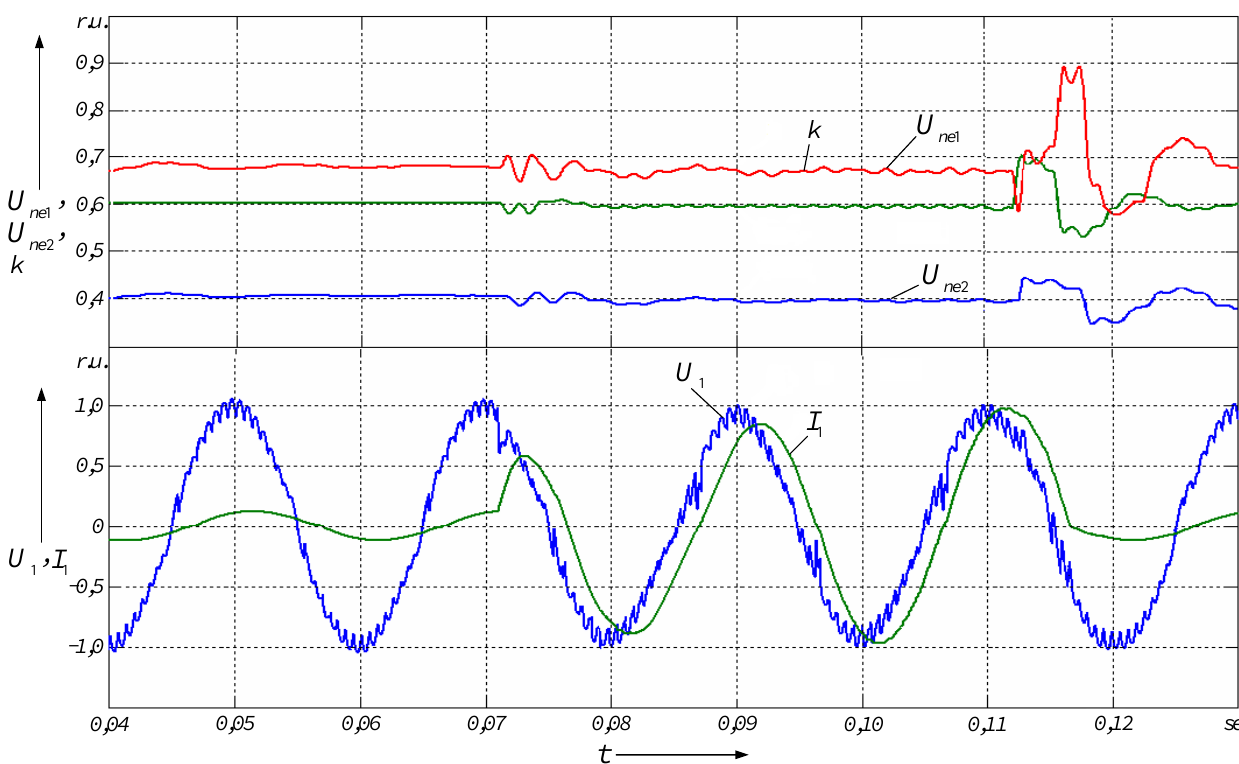
Figure 13. Load voltage and current waveforms of MCS when changing load power while stabilizing output electrical parameters of MCS by means of DC and AC excitation winding